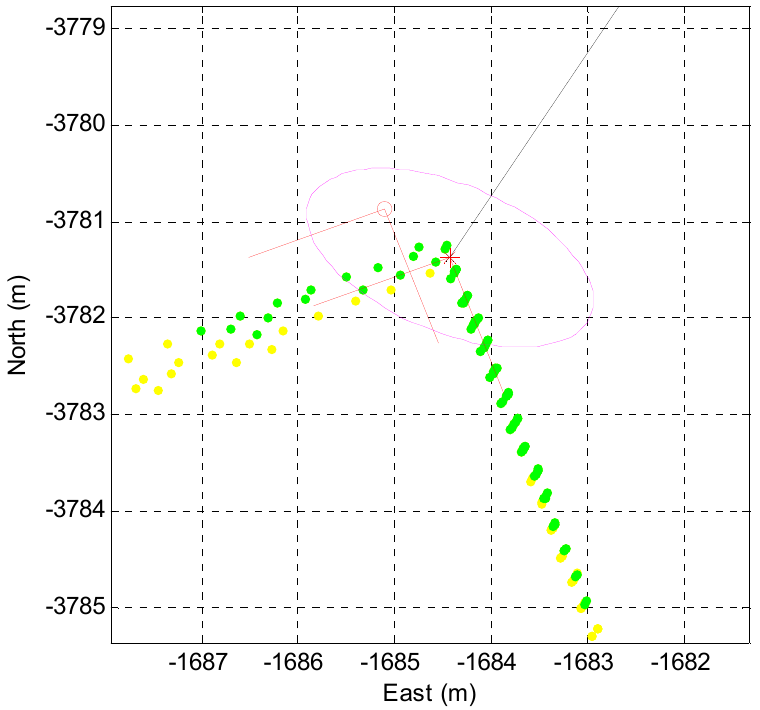
Figure 14. Data association with the corner map.